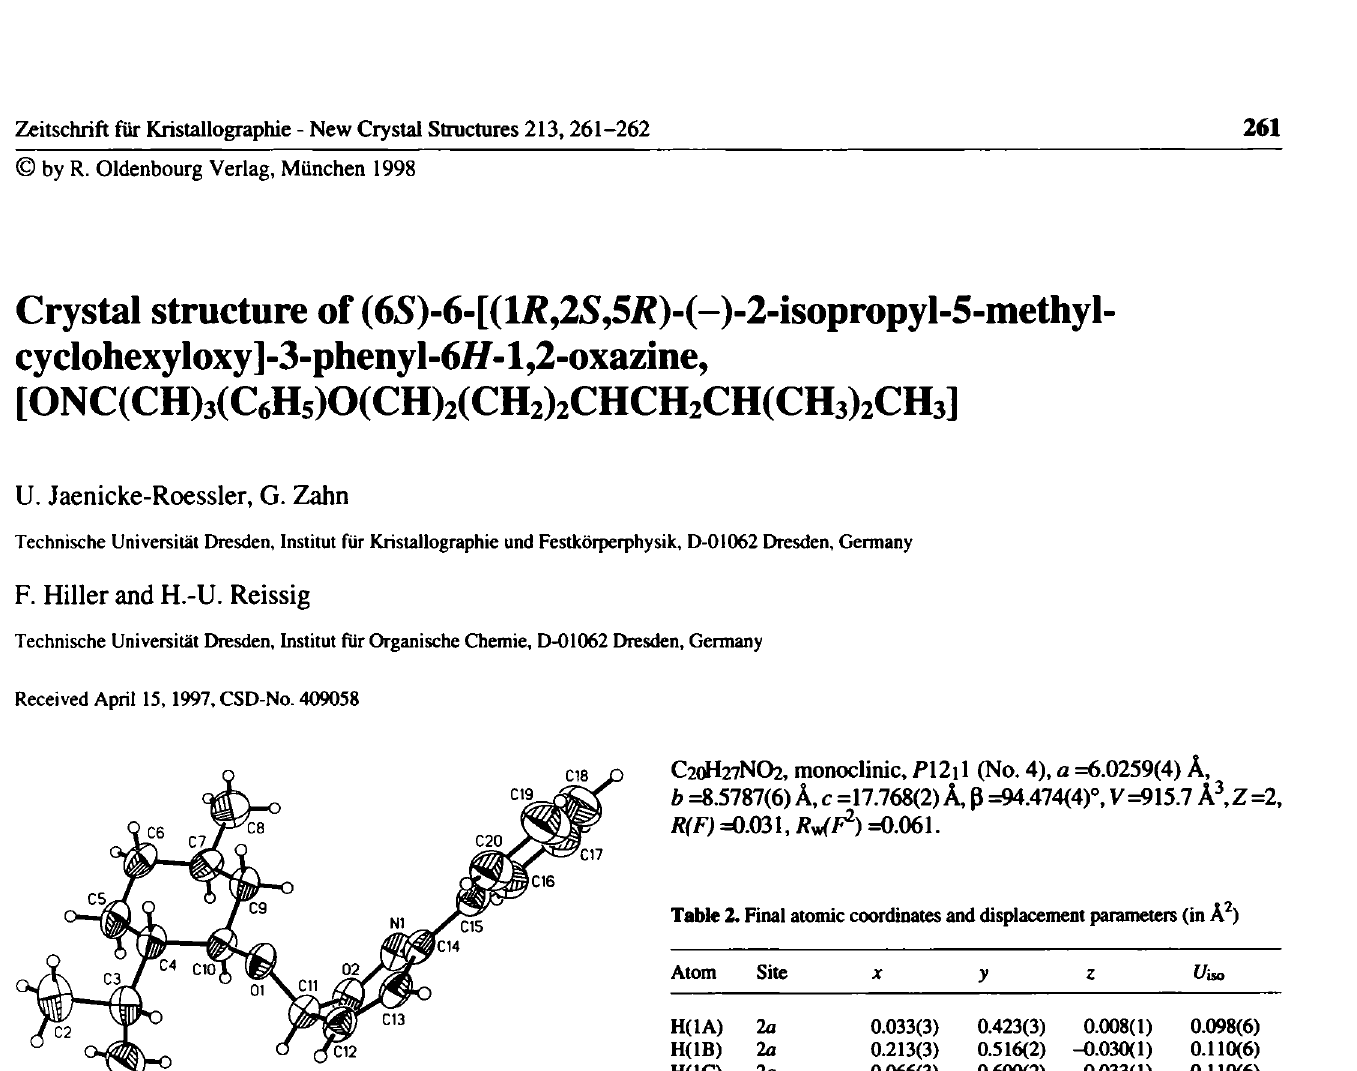
Table 1. Parameters used for the X-ray data collection